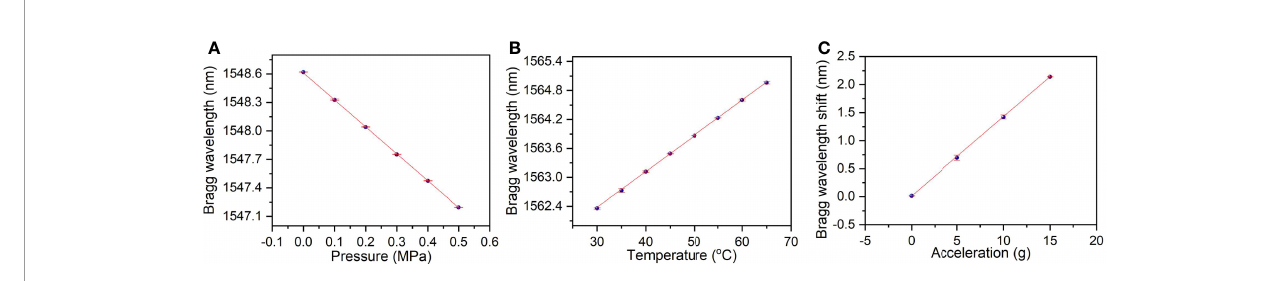
FIGURE 8 | Measured responses of the (A) pressure, (B) temperature, and (C) acceleration sensors fabricated in the same way, where the error bar represents the standard deviation of the